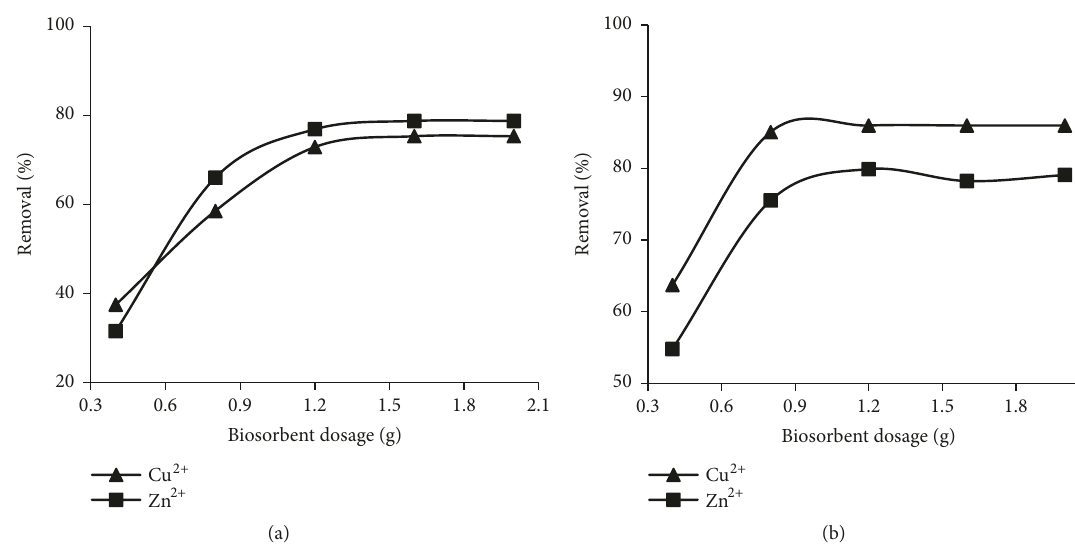
Figure 7: Effect of biosorbent dosage on metal ion removal using (a) EC and (b) Fe 2 O 3 -EC.